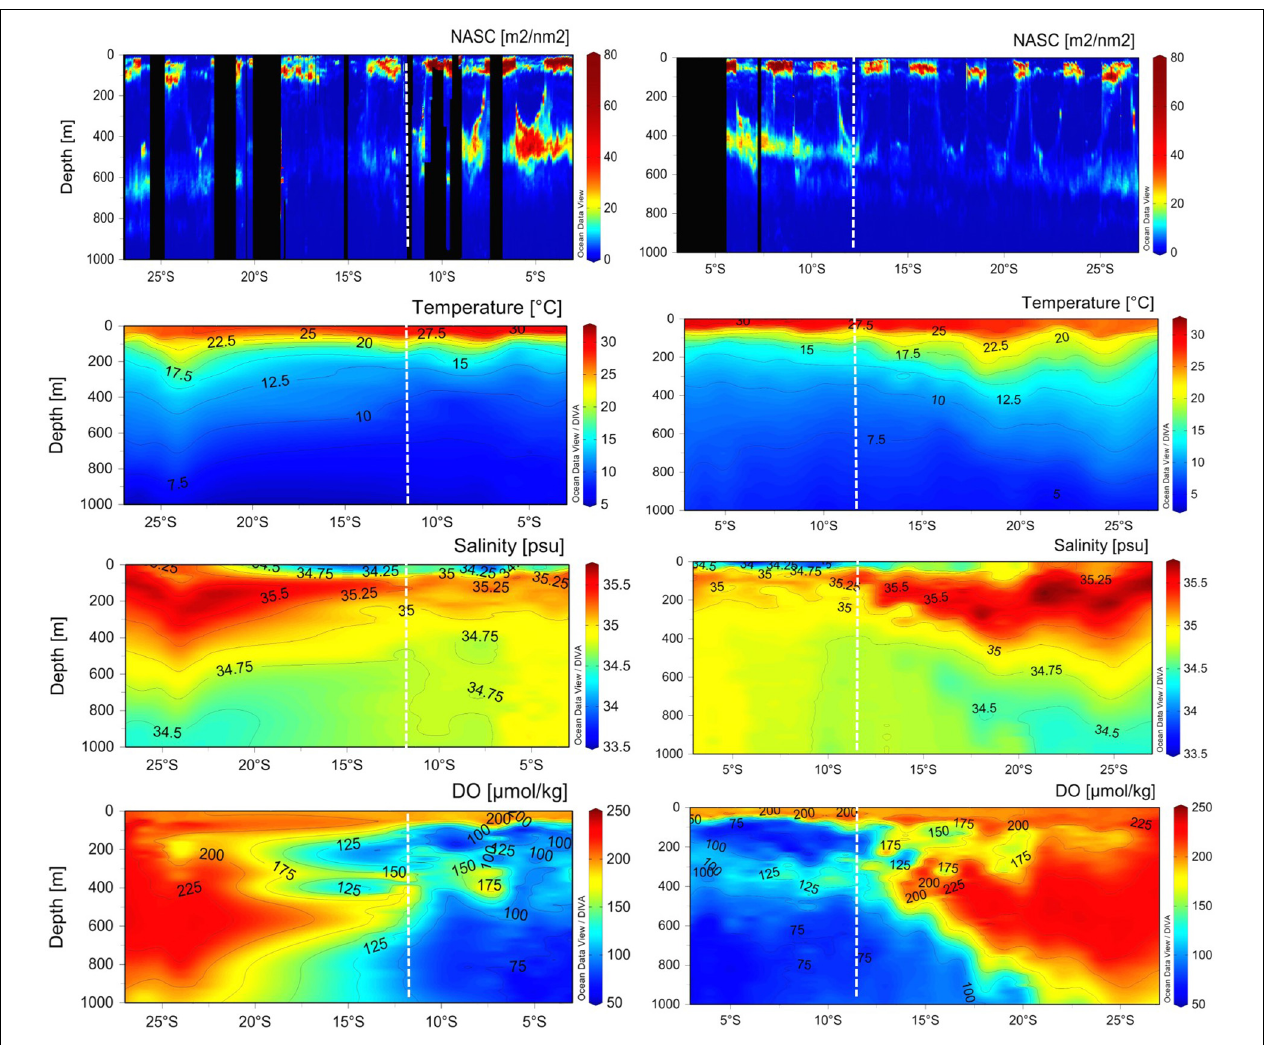
FIGURE 7 | Meridional cross-sections of echogram, interpolated water temperature, salinity, and dissolved oxygen on 60 ◦ E longitude (left panels) and 67 ◦ E (right panels). Note that the NASC echogram was created using average NASC in a cell (30 min × 5 m) which means that it was not interpolated. The vertical black section was no-data because of heavy noise. X -axis ranges from 3 ◦ S to 27 ◦ S latitude. Contour lines with numbers are seen in environmental panels. The vertical dotted line in white in each panel indicates 12 ◦ S latitude. The SCTR extends from 3 ◦ S to 12 ◦ S, showing regions between two white dotted lines. The non-SCTR ranges from 12 ◦ S to 27 ◦